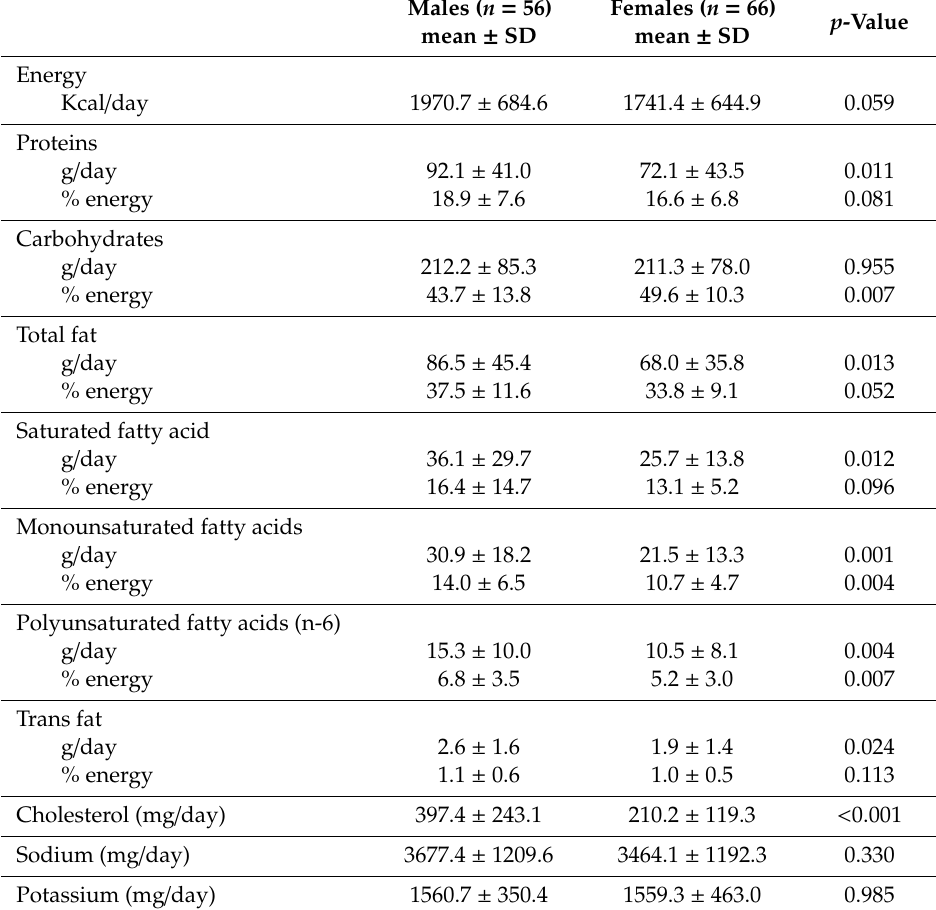
Table 6. Daily macronutrients and energy intake among UOS students ( n = 122) by